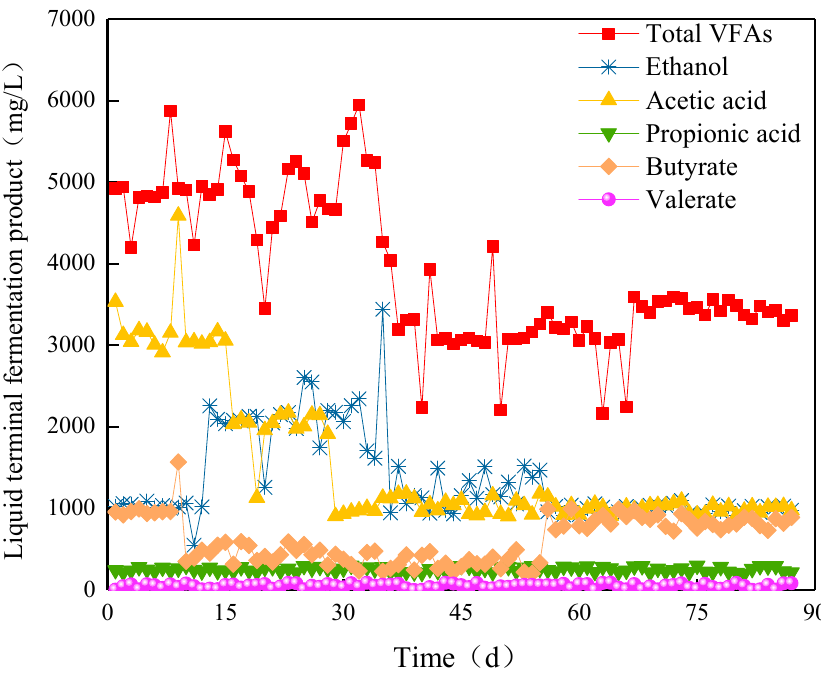
Figure 11. Ethanol and VFAs yields in Compartment IV.